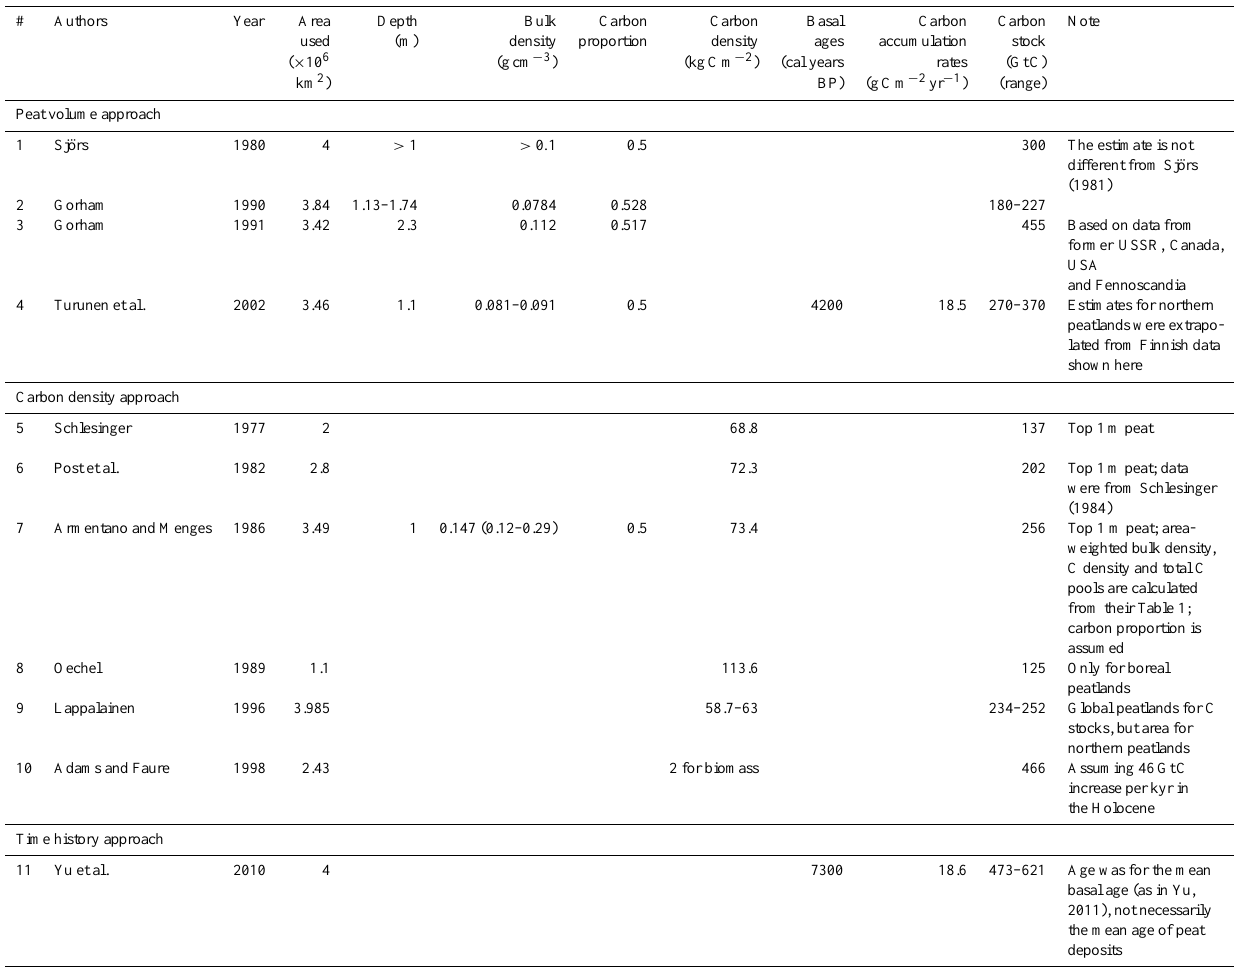
Table 2. Estimates of northern peatland carbon stocks by different